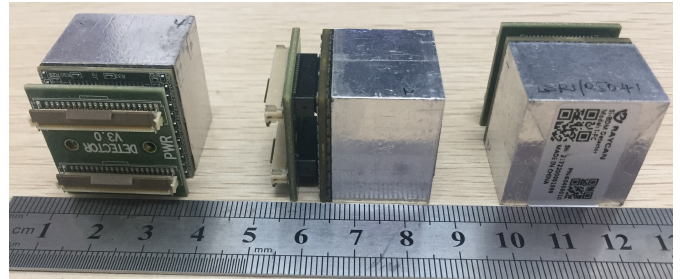
Figure 1. The P&I sensor system. A 6 × 6 array of LYSO crystals with size 3.9 × 3.9 × 20 mm 3 is read out by an array of 6 × 6 SiPM. The assembled block has a dedicated plug-in system for the readout electronics on the